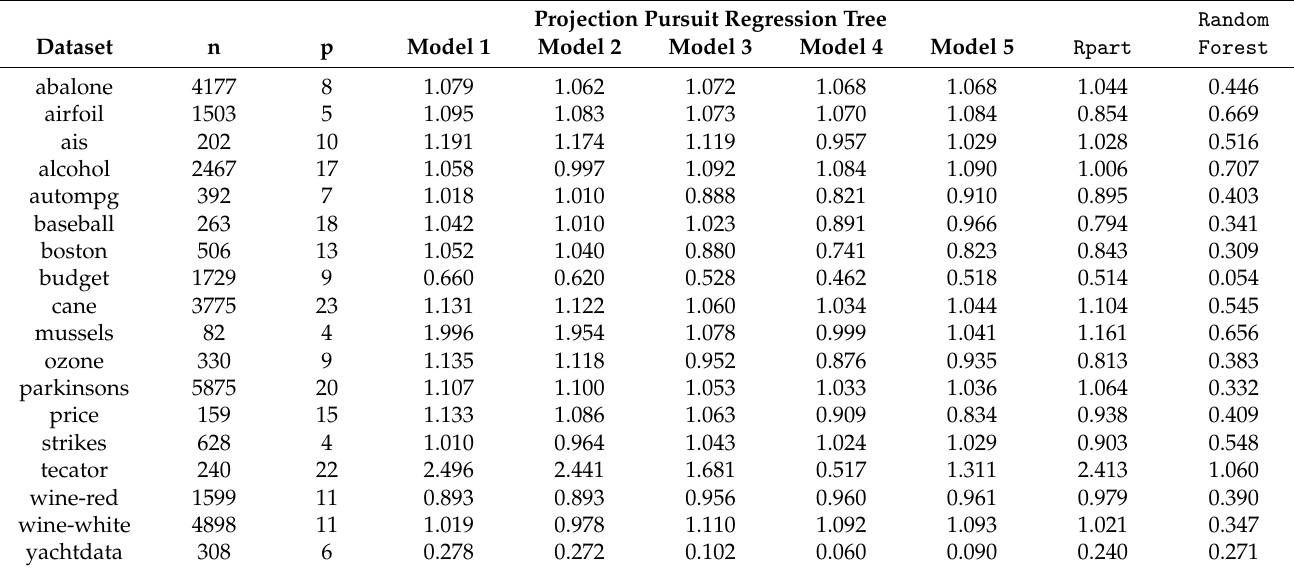
Table 9. Comparison of lm , rpart , randomForest , and the projection pursuit regression tree with various data sets; the mean MAE/MAE( lm )of 200 iterations for the training dataset.